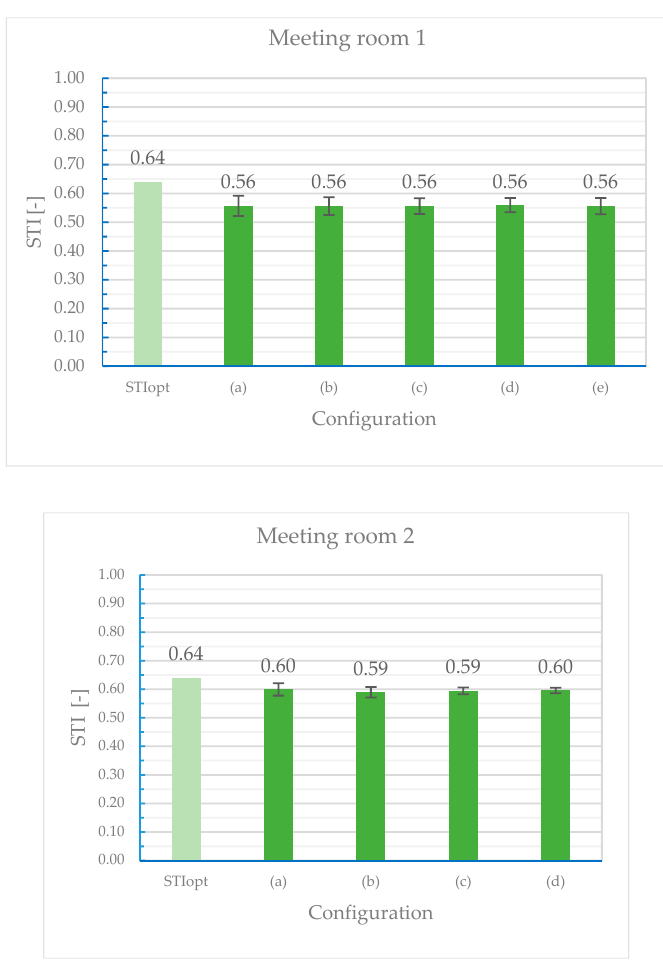
Figure 13. STI spatial average value in the Mr1 and Mr2 simulated with ODEON 15 for the different configurations shown in Figures 5 and 6, and optimal minimum value in unoccupied conditions, STI opt . The error bars represent the standard deviation across different measurement positions.